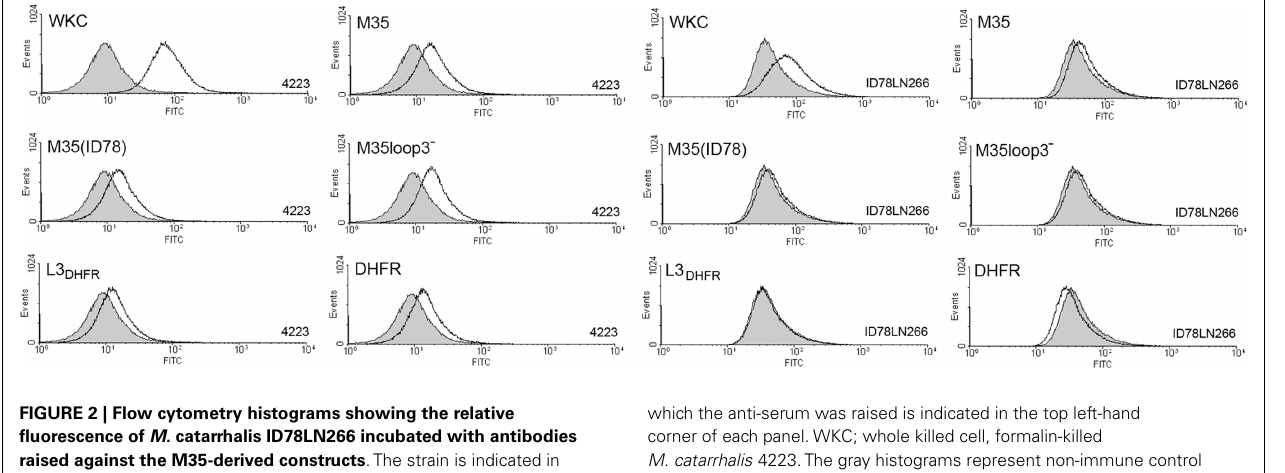
which the anti-serum was raised is indicated in the top left-hand corner of each panel.WKC; whole killed cell, formalin-killed M. catarrhalis 4223.The gray histograms represent non-immune control serum.